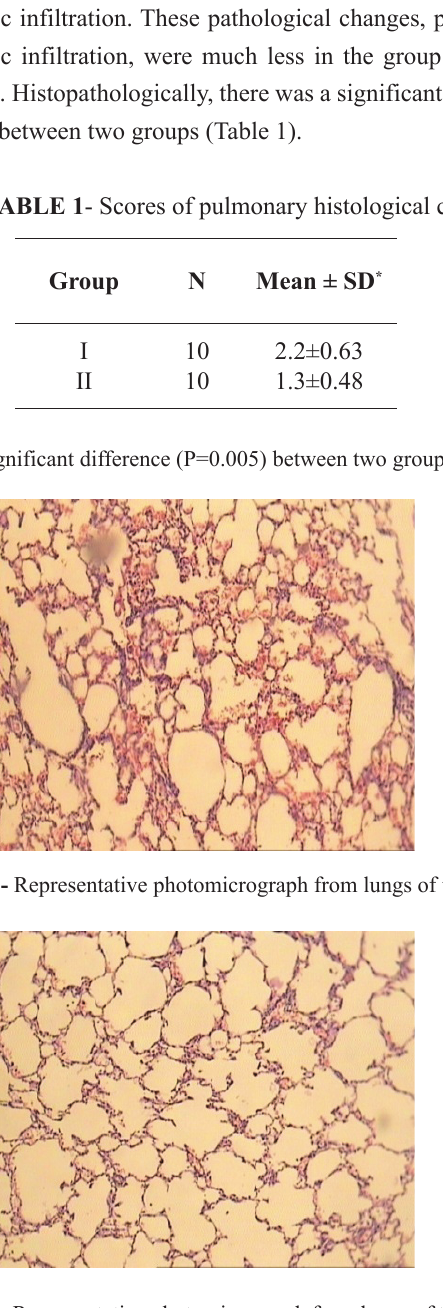
FIGURE 2 - Representative photomicrograph from lungs of the group